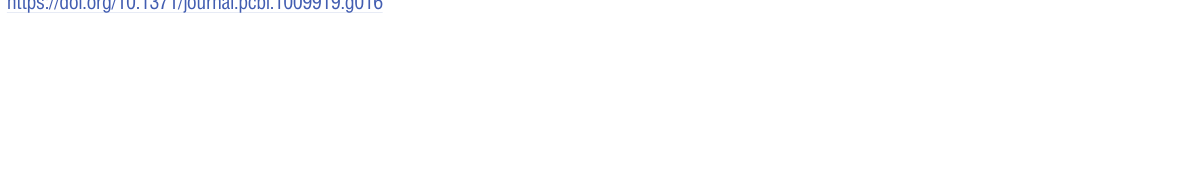
PLOS Computational Biology | https://doi.org/10.1371/journal.pcbi.1009919 March 9,